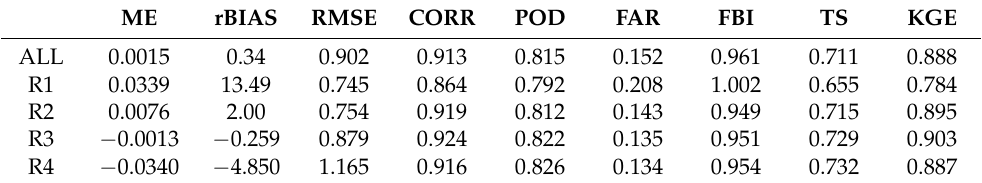
Figure 4. Comparative boxplots of the CMPAS–NRT product for different assessment metrics (including each sub–region and the whole region) in the rain monitoring area during the 2020 Meiyu period, in which the red line in the box indicates the median, the plus sign indicates the mean, and the horizontal lines in each boxplot sub–table indicate the 10th, 25th, 75th, and 90th percentiles of that assessment metric. Panels ( a – h ) respectively represent the ME, rBIAS, RMSE, CORR, POD, FAR, FBI, and TS. Table 1. Statistical values for the comparison between the gauge data and CMPAS-NRT product. The units of ME and RMSE are mm/h; the unit of rBIAS is %.